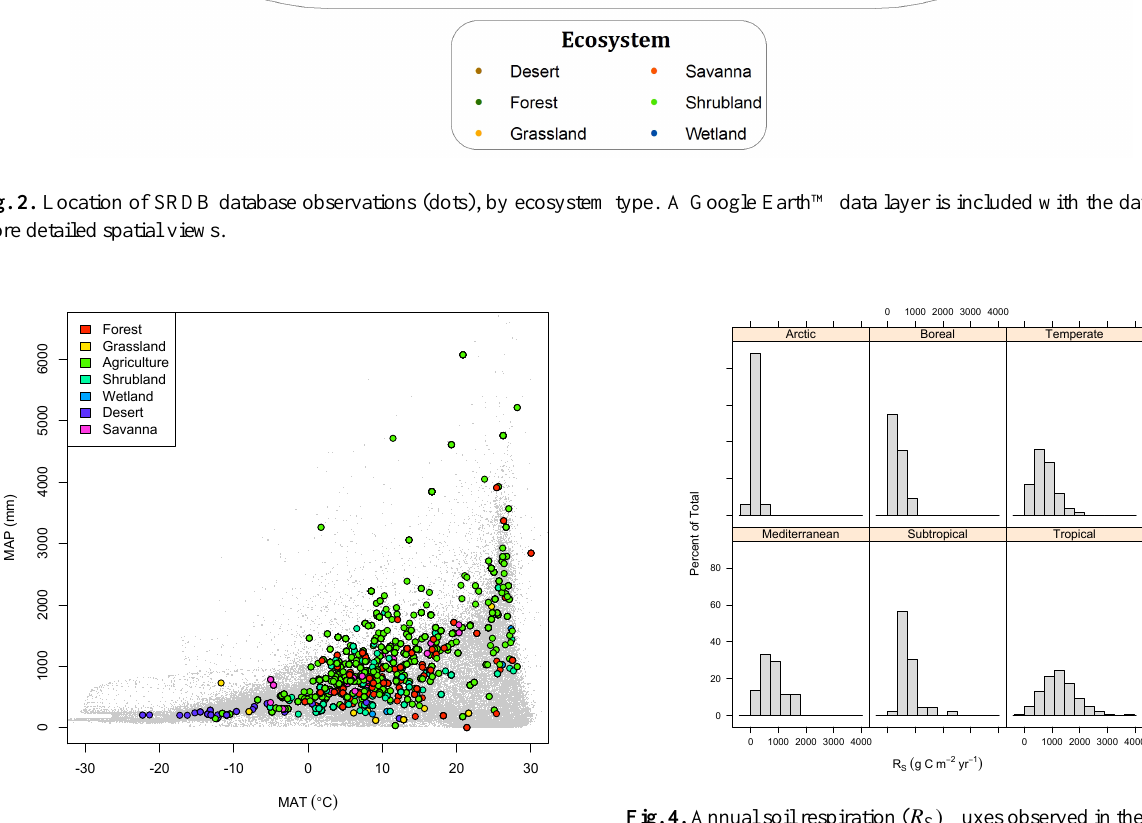
Fig. 3. SRDB data distribution across global mean annual temper- ature (MAT) and mean annual precipitation (MAP) climate space, by ecosystem type. Background dots show climate distribution of terrestrial surface (0.5 ◦ cells).